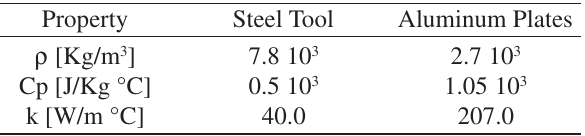
Table 1. Thermal Property.